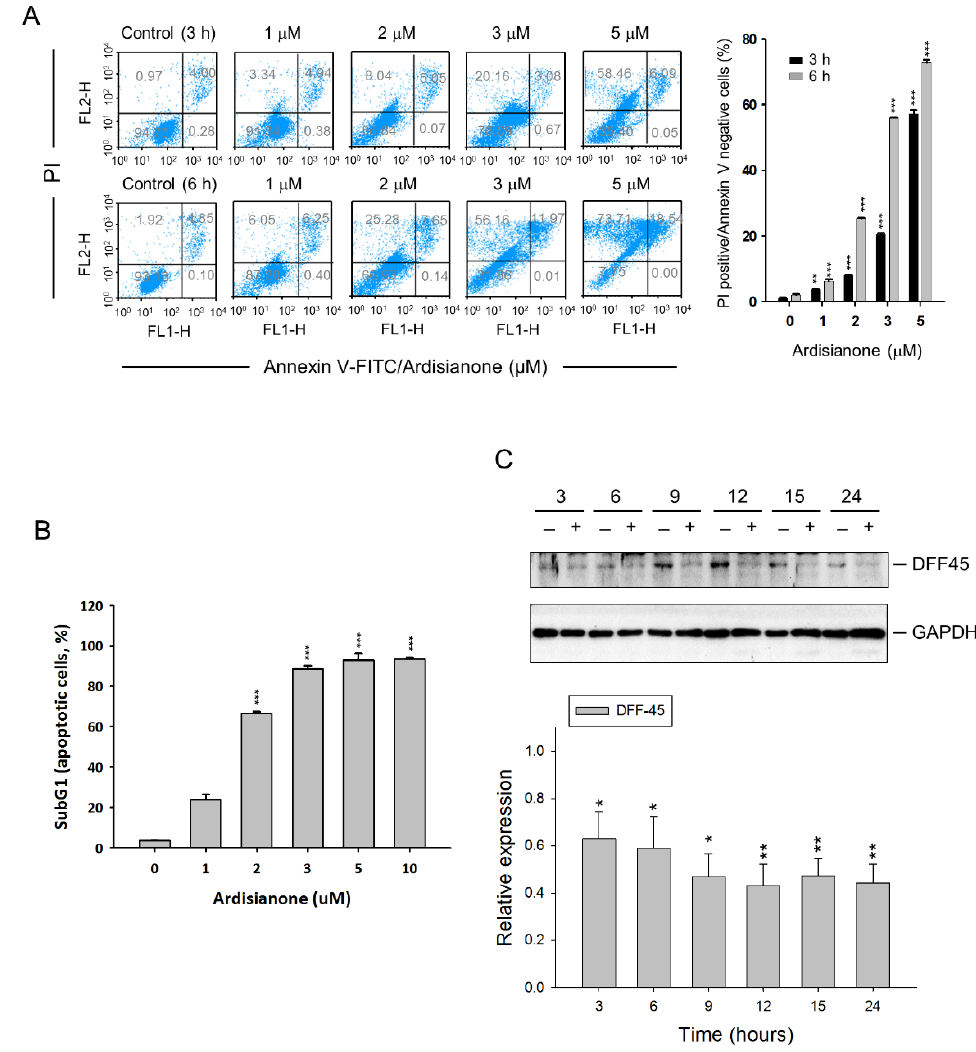
Figure 1. Determination of ardisianone-induced cell death in HL-60 cells. ( A ) Cells were treated with or without ardisianone at the indicated concentration and time. After the treatment, the cells were stained with Annexin V-PI to analyze apoptosis using flow cytometric analysis. ( B ) Cells were treated with graded concentrations of ardisianone for 24 h. After the treatment, the cells were fixed and stained with propidium iodide to analyze DNA content by FACScan flow cytometer, and quantitative analysis of sub-G1 (apoptosis) population was performed. ( C ) Cells were treated with or without ardisianone (2 μM) for 3 to 24 h. Total protein was extracted and subjected to SDS – PAGE for the detection of apoptotic DFF45/ICAD. Protein expression was quantified using Bio-Rad Image Lab TM Software. * p < 0.05, ** p < 0.01, and *** p < 0.001 compared with respective controls.